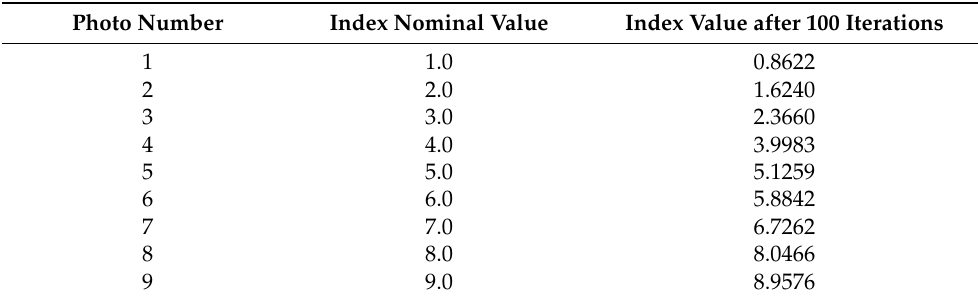
Table 1. Values of the Recognition Index of each person.